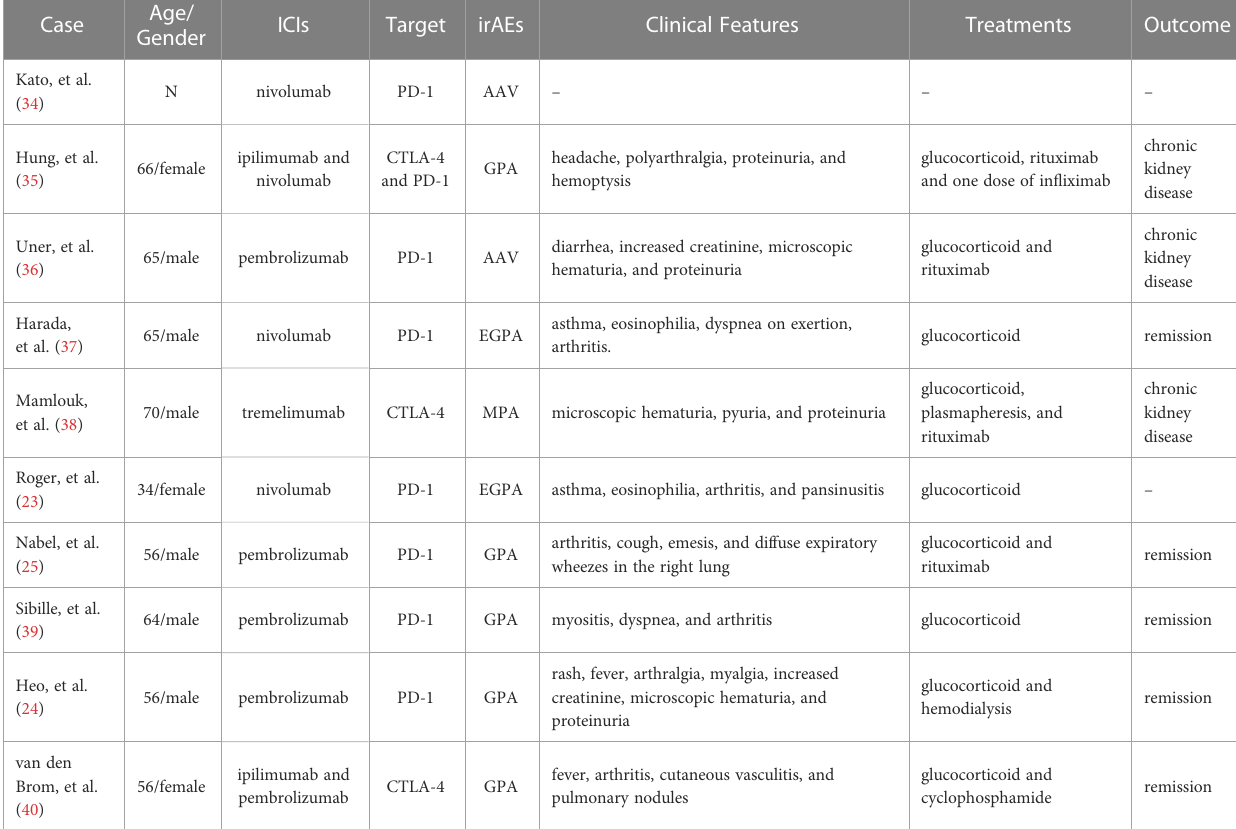
TABLE 1 Demographic characteristics and clinical data of patients with ICIs-induced AAV.